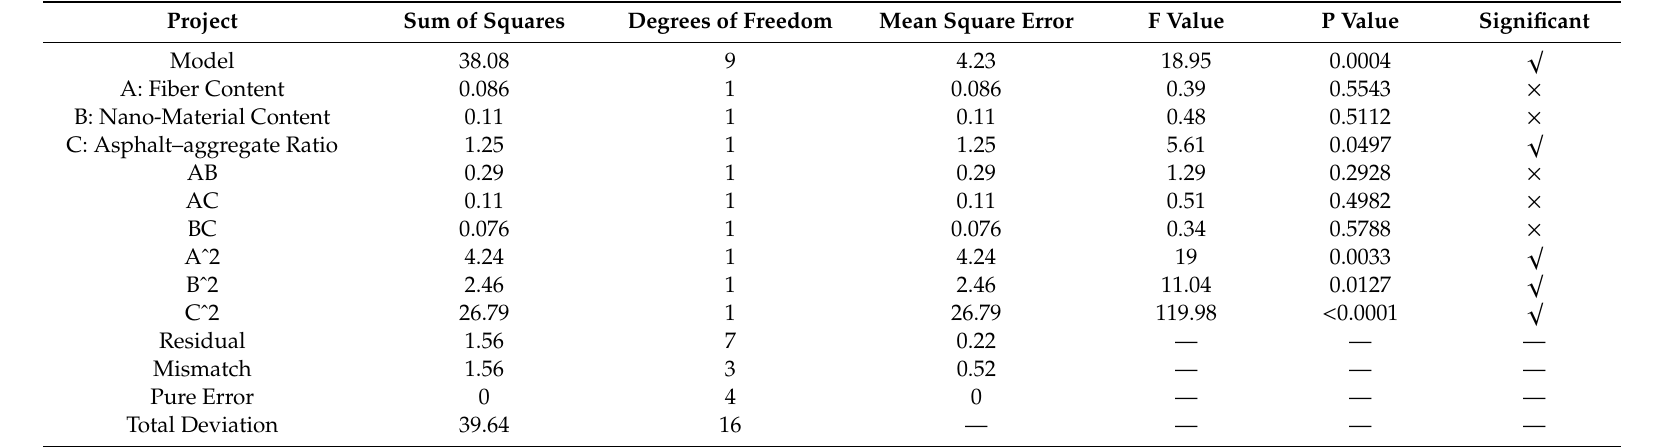
Table 16. Marshall stability variance test